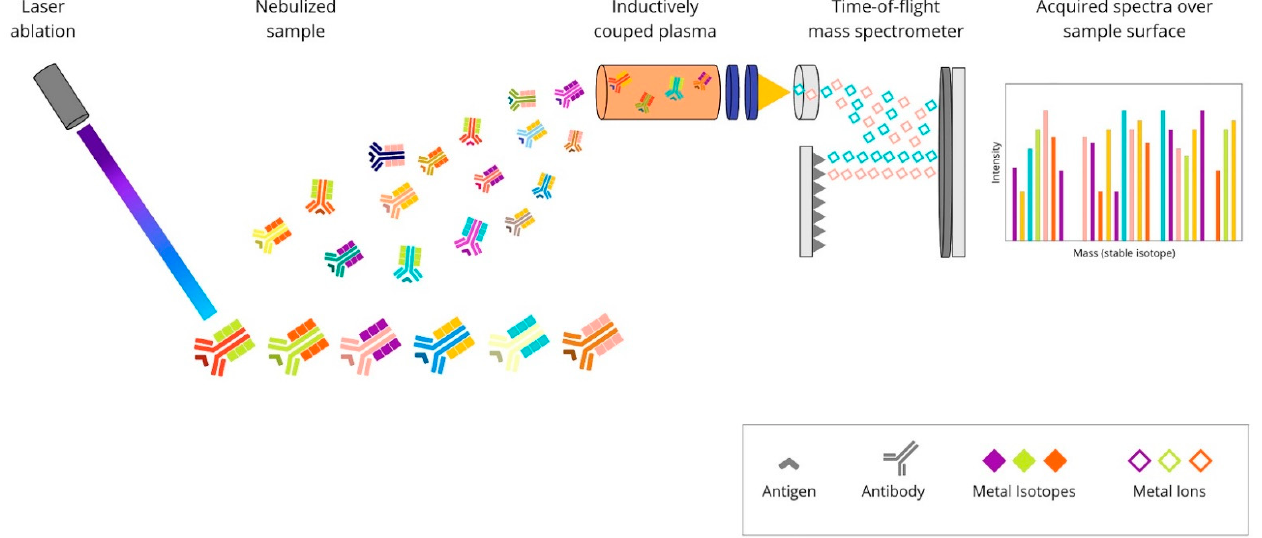
Figure 4. Overview of imaging mass cytometry technique: A mixture of antibodies is labelled with isotopically pure metal-chelator tags. Each antibody binds to a single protein target. Then, the sample is ablated using a laser beam. It generates the separation of particles, which are then carried by a helium/argon mixture stream into a time-of-flight mass spectrometer, where metal ions are separated based on mass. The measured reporter signals are then mapped using the coordinates of each laser spot, and finally, an image is generated based on these data.